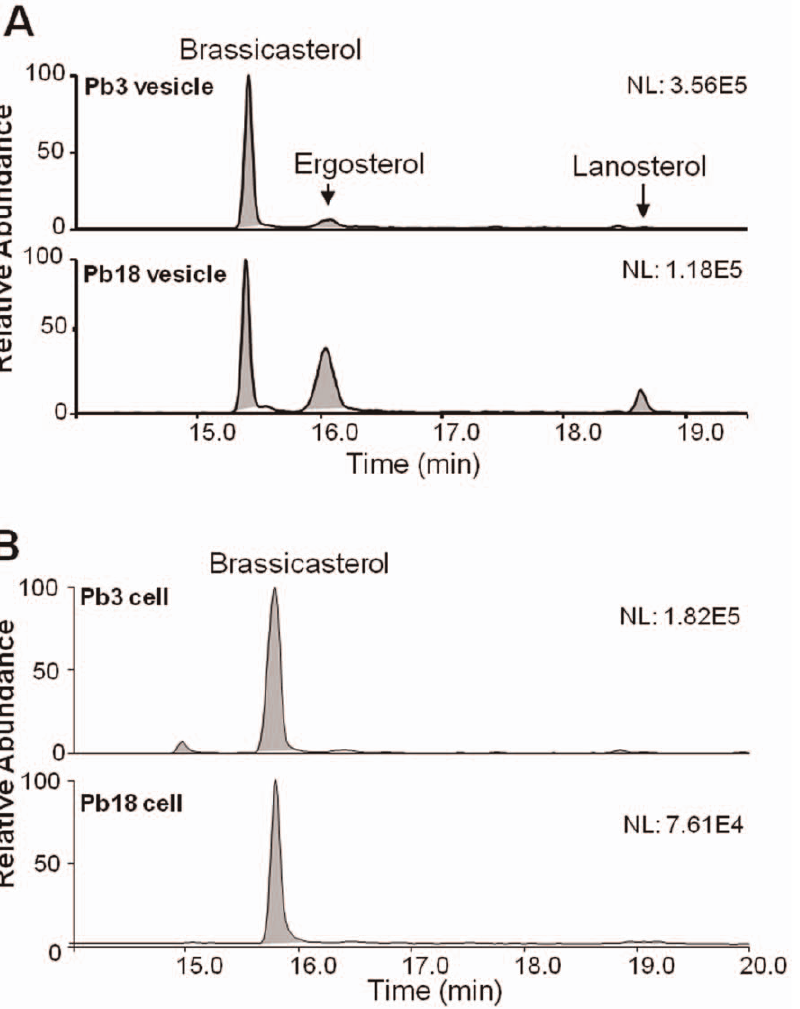
Figure 3. GC-MS sterol analysis of Pb3 and Pb18 extracellular vesicles. Sterol-enriched fractions of total lipids extracted from Pb3 and Pb18 extracellular vesicles (A) or yeast cells (B) were directly analyzed by GC-MS without previous derivatization. Extracted-ion chromatograms were generated by plotting diagnostic fragment ions for sterol species at m/z 368, 386, 384, 398, 395, 396, 412, and 426.